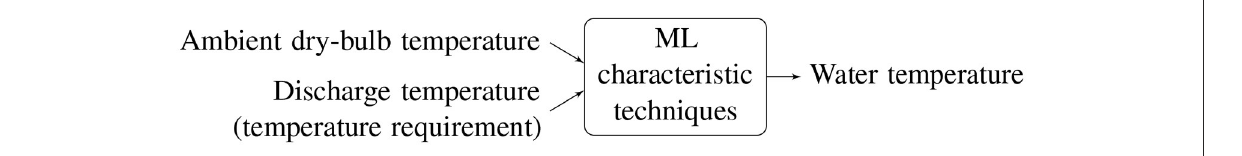
FIGURE3 Input variables and output variable of the various characteristic models.